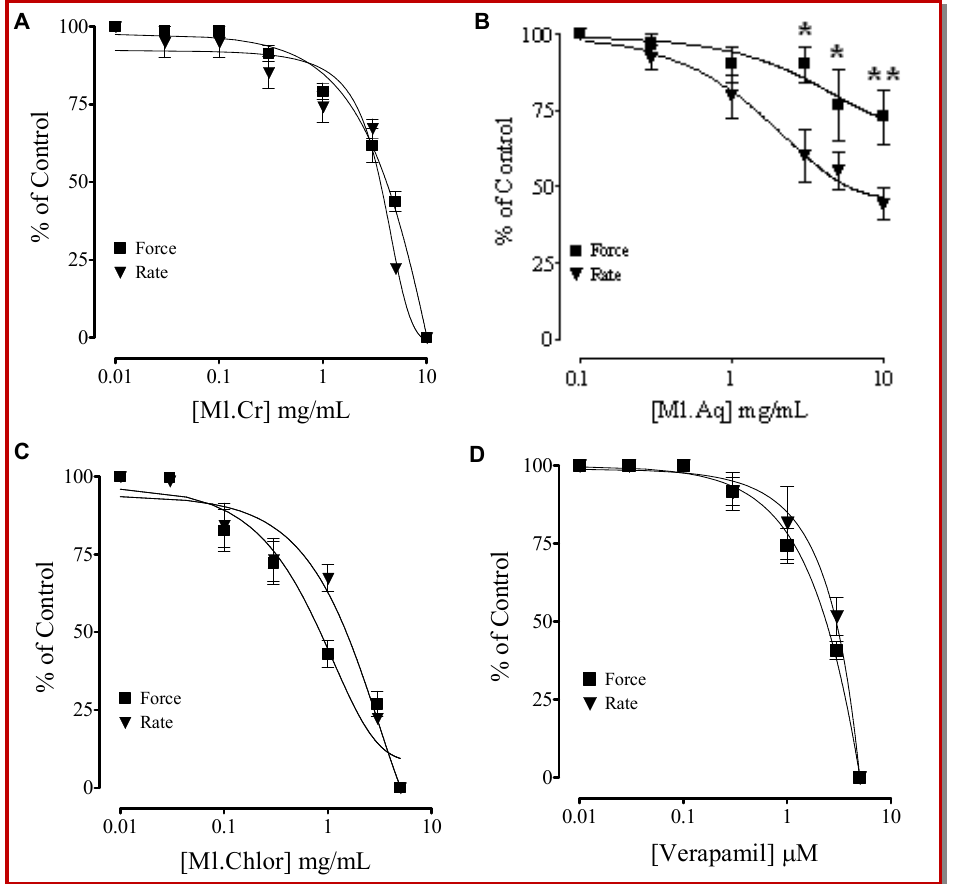
Figure 4: Inhibitory effect of (A) the crude extract of M. longifolia (Ml.Cr); (B) aqueous (Ml.Aq) and (C) chloroform (Ml.Chlor) fractions and (D) verapamil on the force and rate of spontaneous atrial contractions in isolated guinea pig atrial preparations. Values shown are mean + SEM (n = 4-6). * p<0.01, **